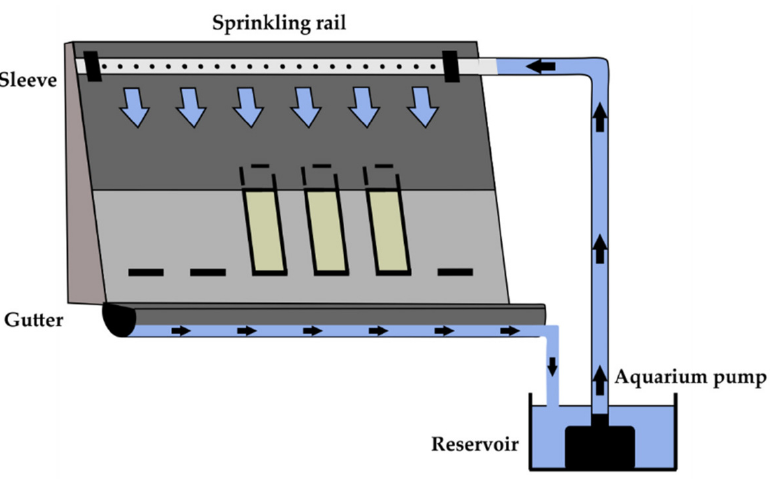
Figure 1. Schematic drawing of the setup to simulate rain by water runoff. Table 1. Overview of the different samples, including stone type, exposed treatment and water exposure during the experiment. Samples 1 to 6 were treated by enzymes. Rain was simulated over the biofouled surface of samples 1–3, 7 and 8 using water runoff, whereas the biofilms of the other samples were periodically wetted by capillary uptake. Exposure to Runoff No Exposure to Runoff Enzyme-based treatment 1. Savonni è res 4. Savonni è res 2. 5.